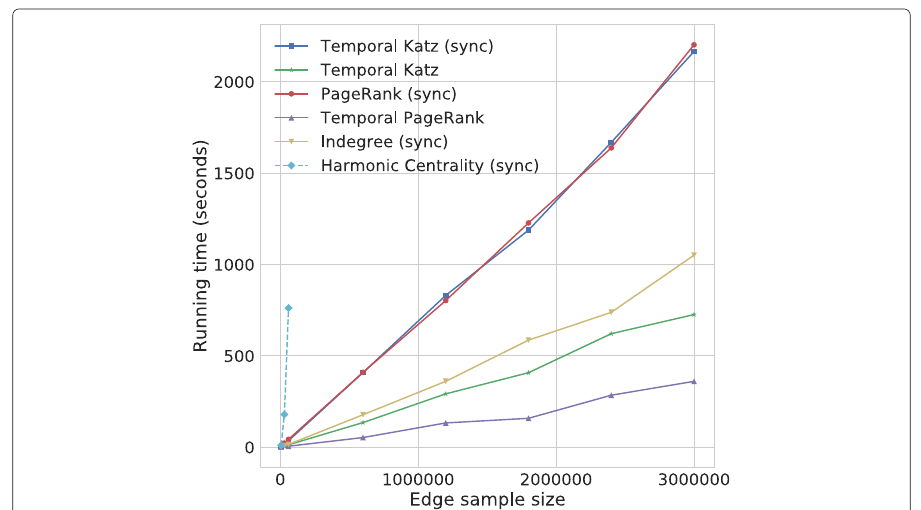
Fig. 4 The running time of temporal PageRank, static PageRank, static indegree, harmonic centrality, and temporal Katz centrality with and witout synchronizing with time decay as in Eq. (14), measured over random Barabási–Albert graphs with sizes as in Table 1. All static centrality measures are considered to be synchronized